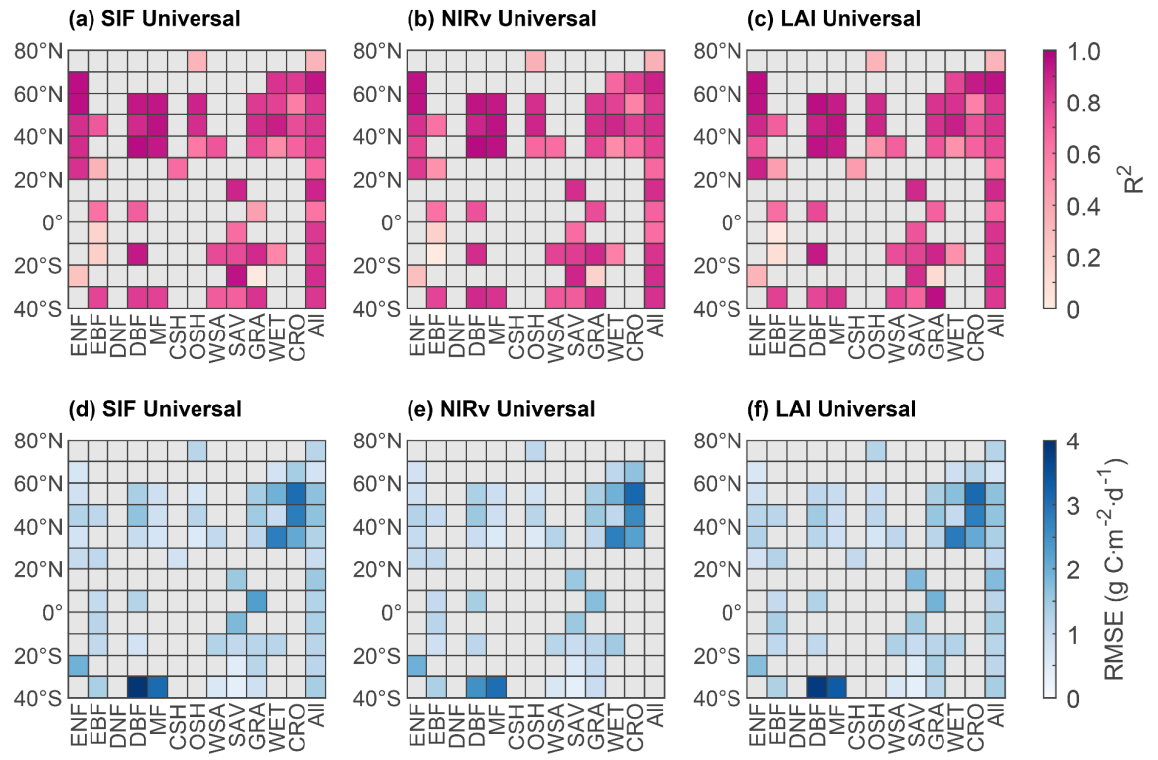
Figure 2. Universal models’ performance for each PFT along different latitude gradients using the RF method. ( a – c ) The R 2 values of the universal models that each vegetation index used as one of the model predictors. ( d – f ) The RMSE values of the universal models that each vegetation index used as one of the model predictors. The gray squares represent that there is no flux tower for the corresponding PFT and latitudinal band.